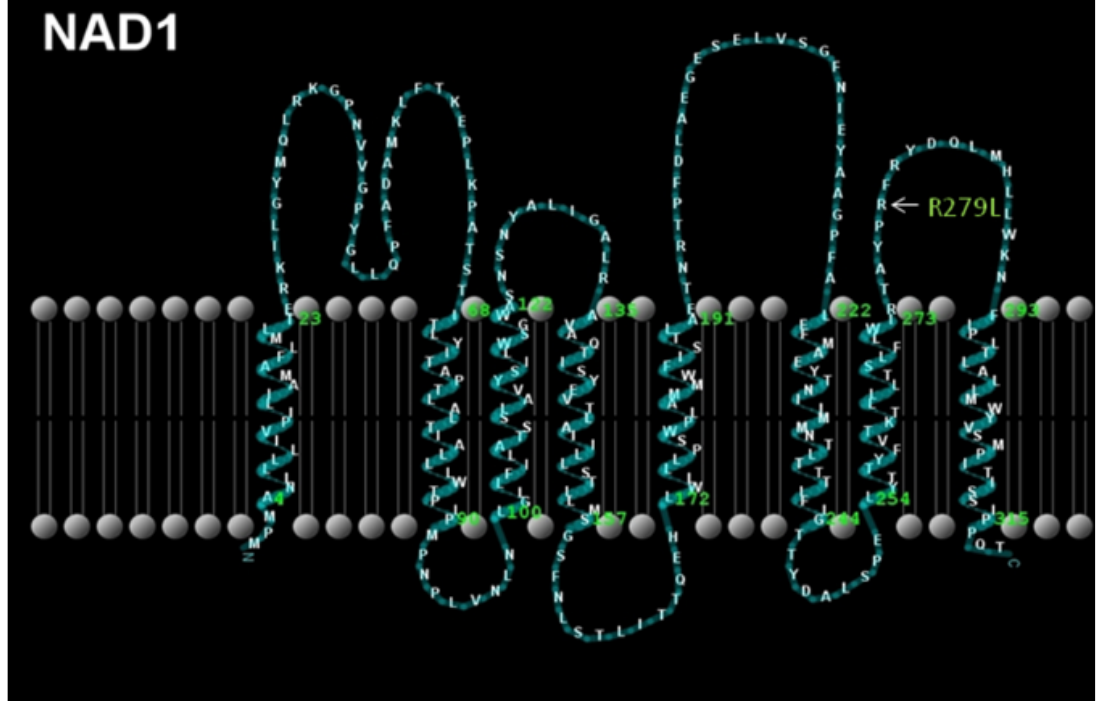
Figure 4. Localization of the m.4142G>T (p.R279L) on the MT-ND1. The biochemical activity of the ND1 subunit of complex I is deficient in patient